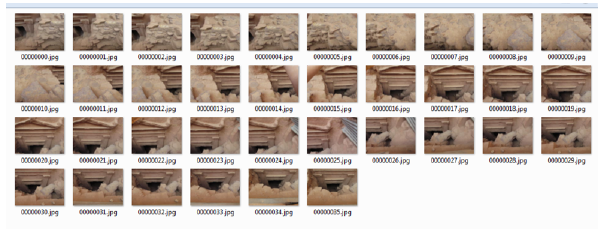
Figure 4. The set of images shot during the acquisition campaign: in this example, the images of the left door are reported.